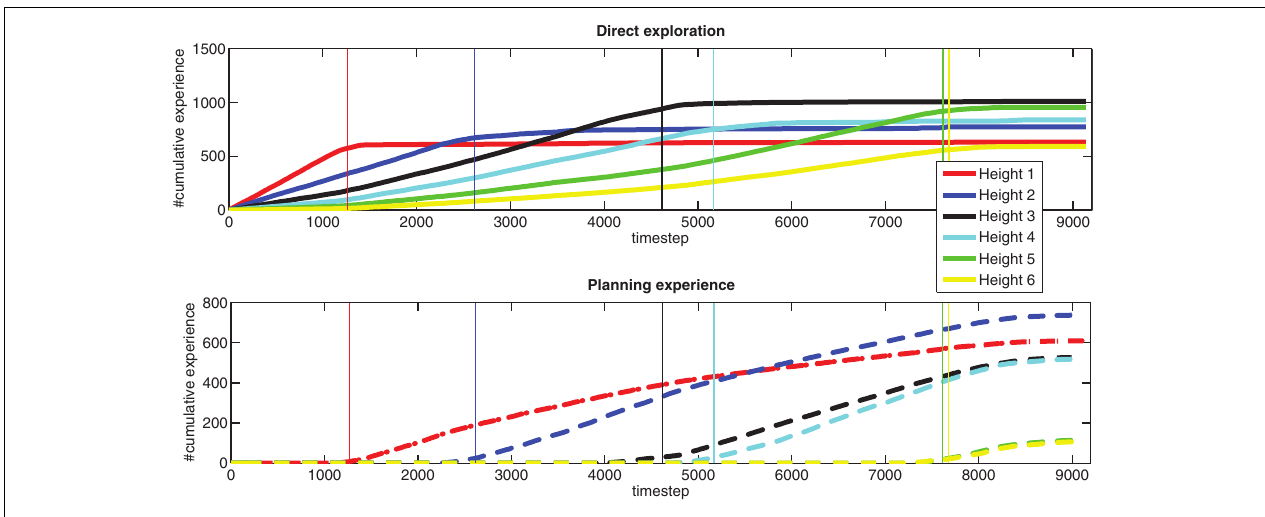
FIGURE 4 | Exploration history (averaged over 10